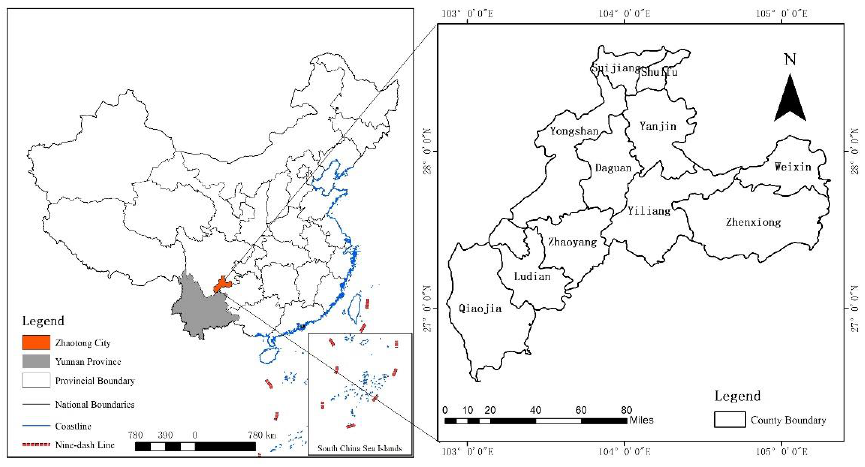
Figure 2. Location and slope map of Zhaotong city.